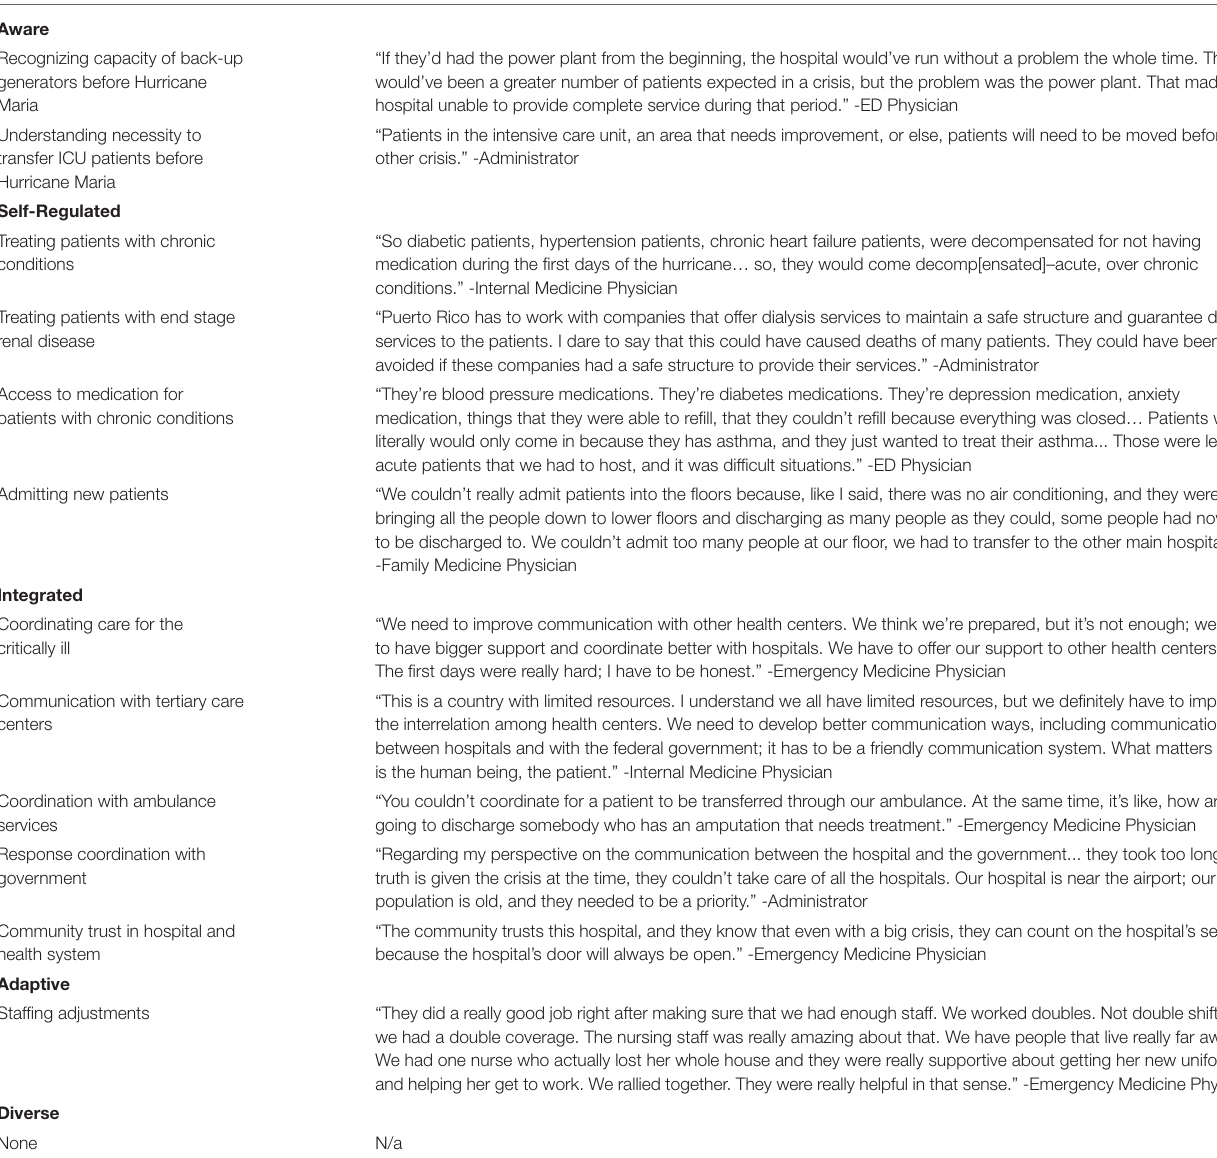
TABLE 4 | Hospital/Health System Themes and Sub-themes with Representative